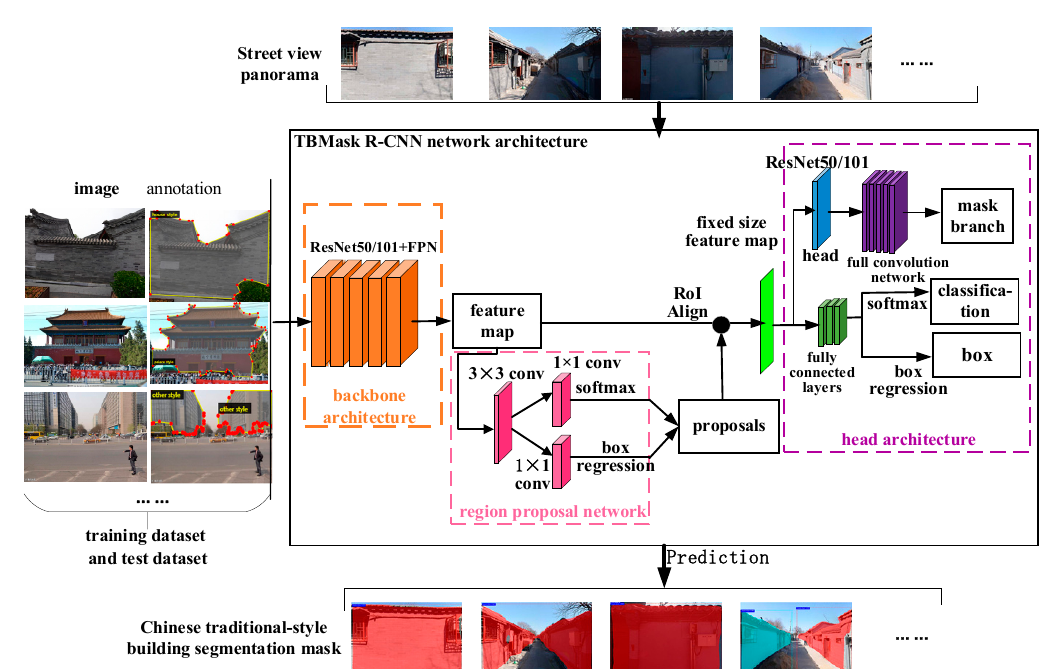
Figure 4. The traditional building mask region-based convolutional neural network (TBMask R-CNN) framework for Chinese traditional-style building segmentation.